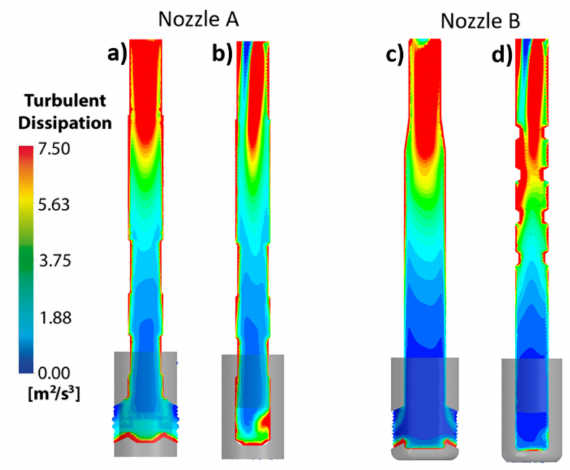
Figure 15. Turbulence eddy dissipation contours in the nozzles without clogging. ( a ) Longitudinal plane axis of symmetry of nozzle A. ( b ) Longitudinal plane axis of symmetry of nozzle A at 90 ◦ . ( c ) Longitudinal plane axis of symmetry of nozzle B. ( d ) Longitudinal plane axis of symmetry of nozzle B at 90 ◦